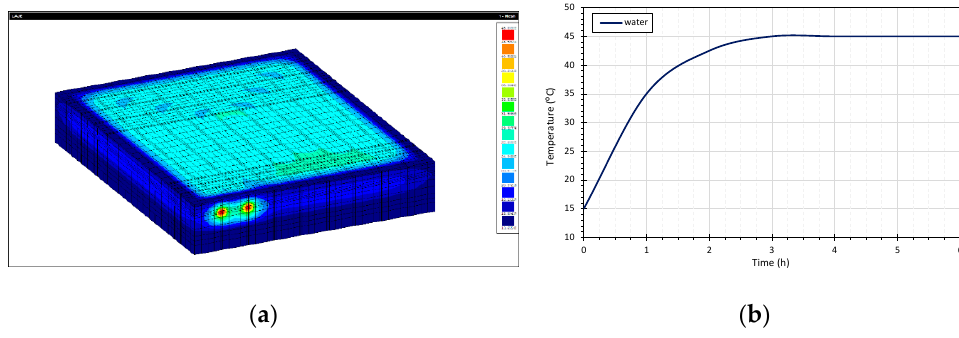
Figure 6. ( a ) FE three-dimensional model; ( b ) water temperature profile.